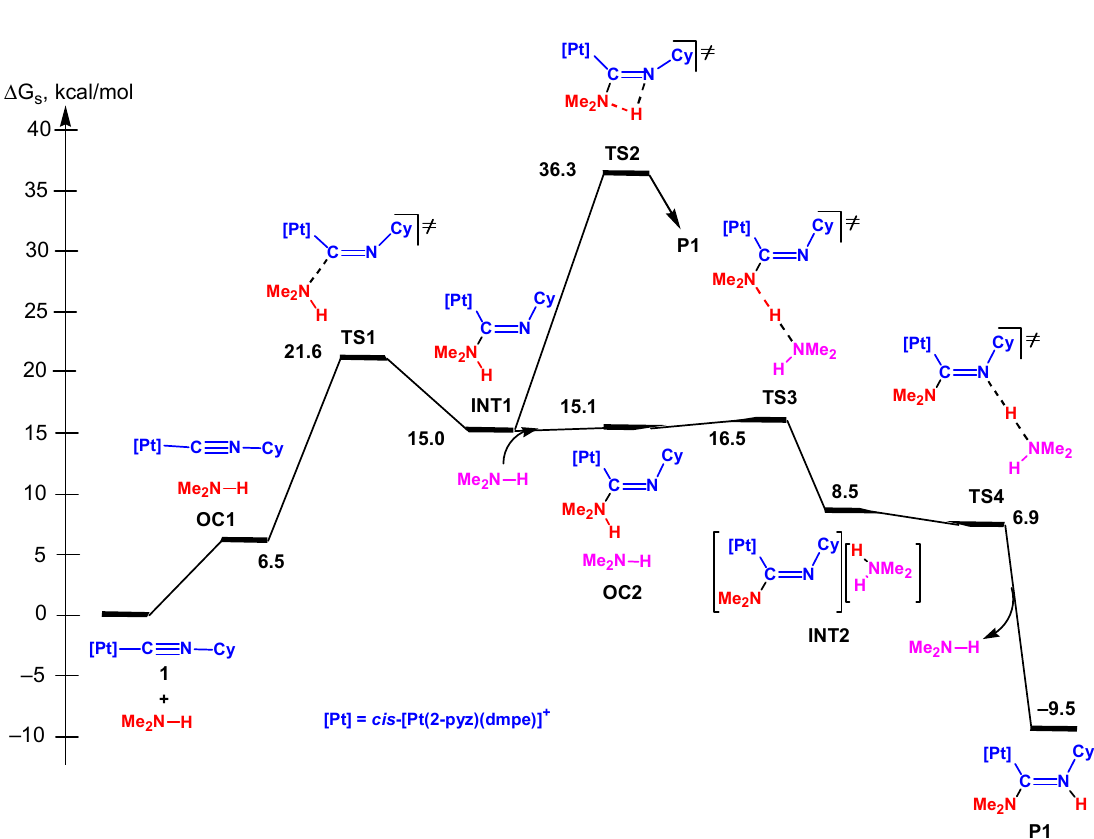
Figure 3. Energy profile for the associative mechanism of the nucleophilic addition of HNMe 2 to cis -[Pt(C ≡ NCy)(2-pyz)(dmpe)] + .